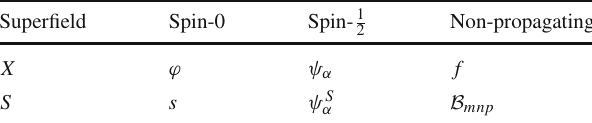
Table 1 The off-shell degrees of freedom of the ordinary chiral super- field X and of the double three-form multiplet S . The complex auxiliary field f of X is replaced by a complex gauge three-form in the variant version